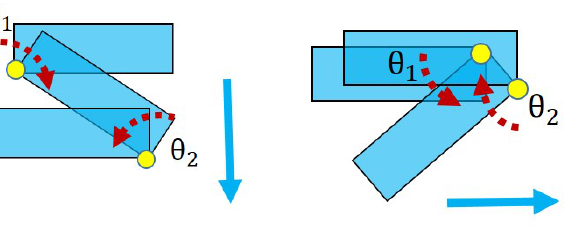
Figure 8. Examples of moving an object to certain direction through pivoting gait. The red dashed arrows indicate rotating directions. θ i indicates the amount of yaw rotation in the i -th sequence.